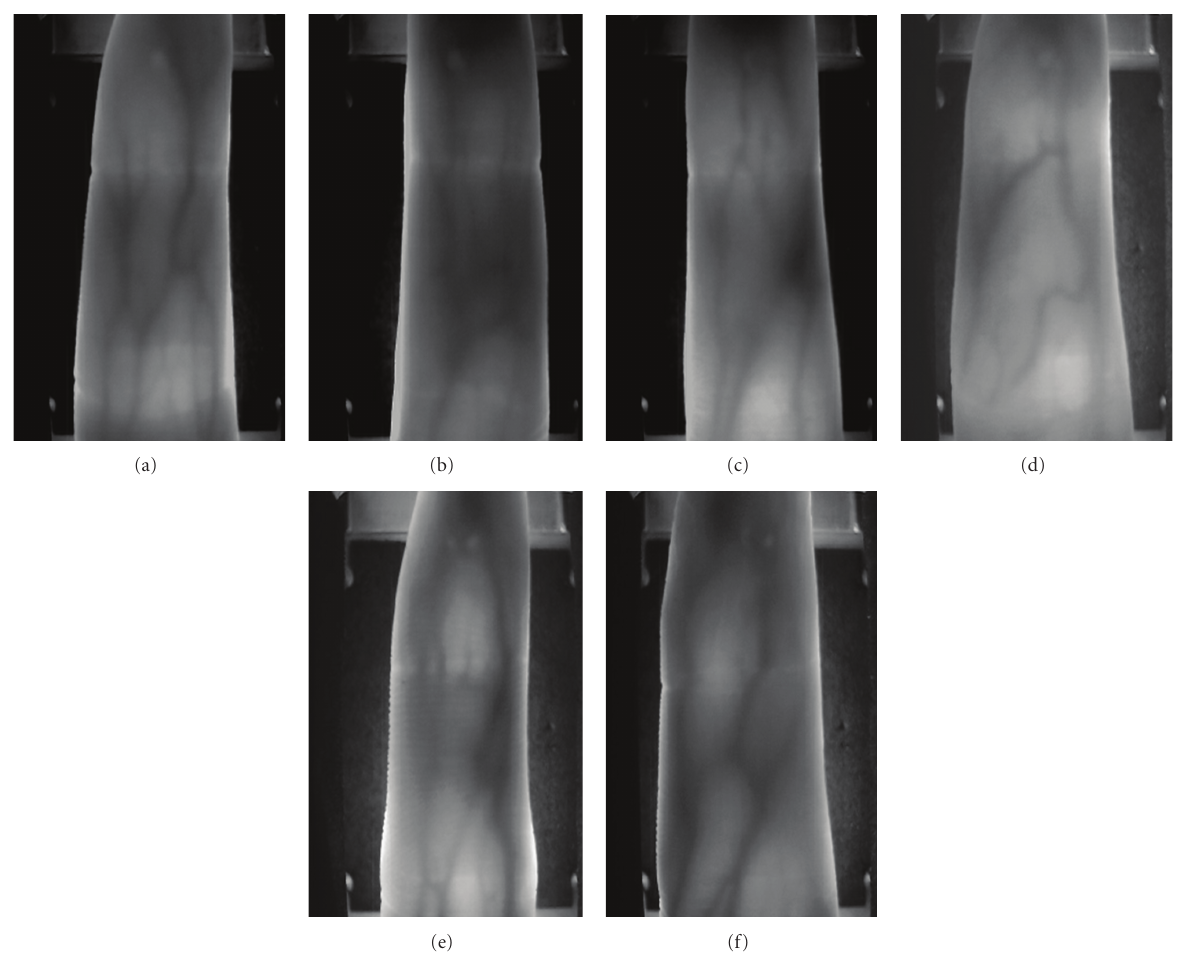
Figure 5: Sample finger vein